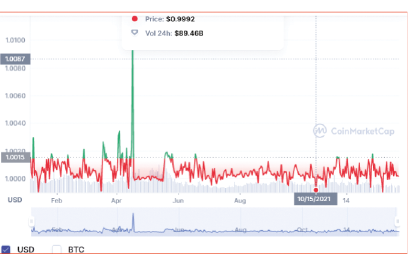
4: 1Tether � 1.00USD (https://coinmarketcap.com/ currencies/tether/?period �